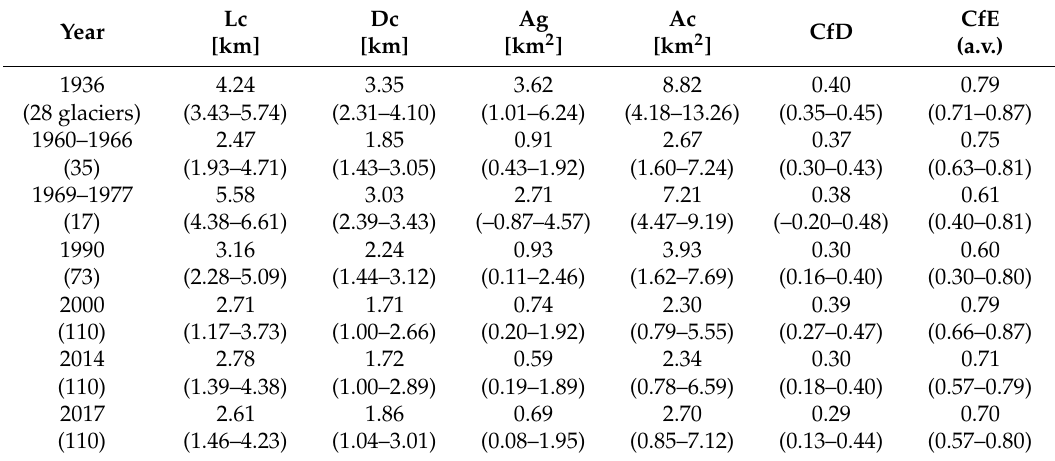
Table 1. Median values of morphometric parameters of glacier frontal zones of Spitsbergen tidewater glaciers (the interquartile range IQR is given in